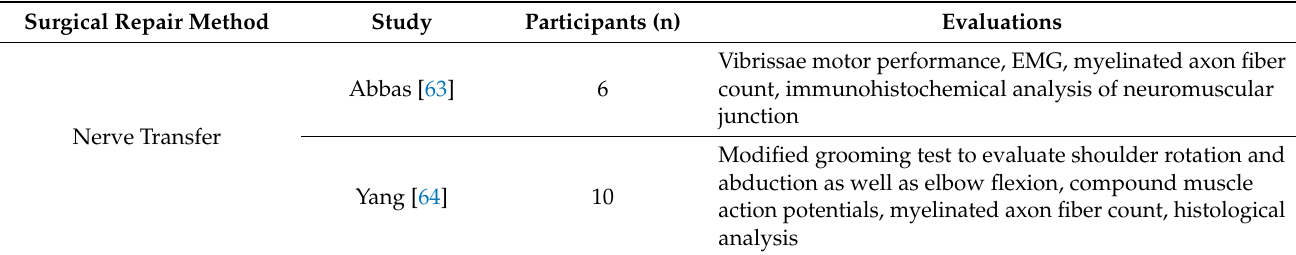
Table 4. Participant number and outcome evaluations from studies of animal nerve transfers with use of ADSCs. Only studies that evaluated at least one functional outcome are listed in the